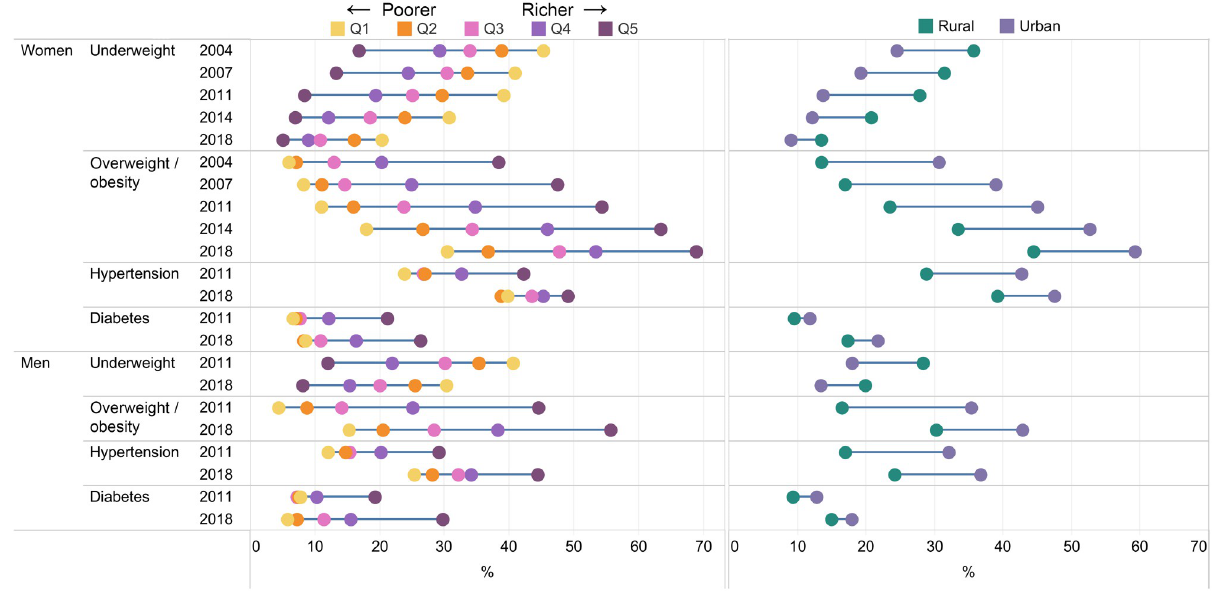
Fig 5. Socio-economic and residential inequality in underweight, overweight/obesity, diabetes and hypertension among women and men by survey round, Bangladesh 2004–2018.